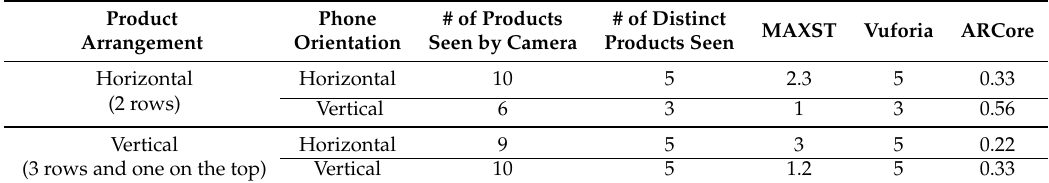
Table 2. Average number of products simultaneously recognized and tracked (distance: 70